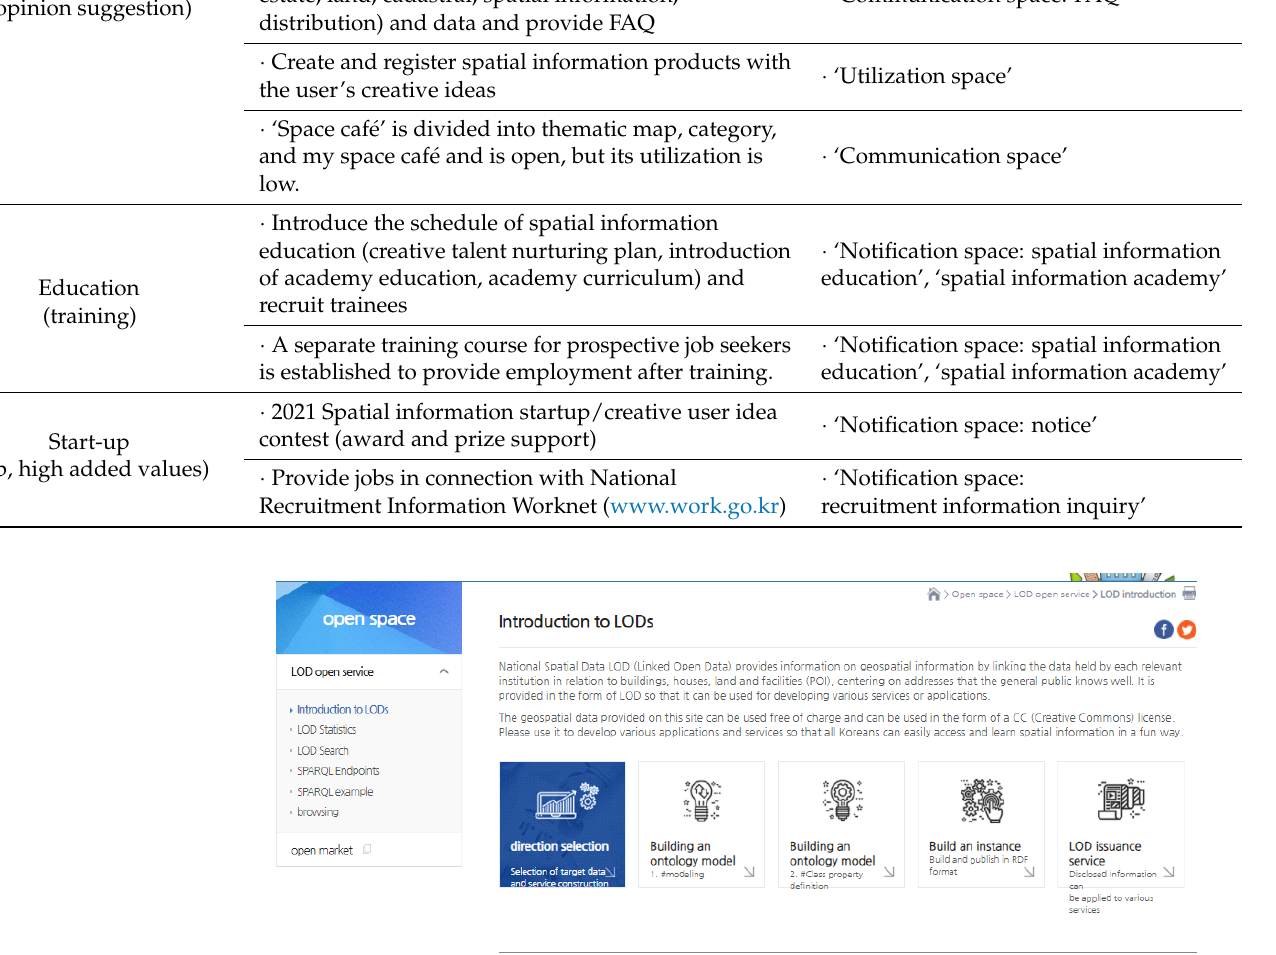
Figure 12. Providing spatial information by LOD in 'open space'. National spatial information LOD (linked open data) is provided in the form of LOD so that it can be used for application development by linking data related to buildings, houses, land, and facilities to addresses (Figure 12). The ontology model is a structure for expressing national spatial information data in RDF/XML format and consists of classes for buildings, houses, land, and facilities. The relationship of each class is connected with the address as the center. ‘What is spatial information?’ provides basic knowledge of spa- tial information by introducing the basic concept, necessity, and history of spatial infor- mation. Then, ‘spatial information utilization field’ mainly introduces the use of public institutions and industries. In the ‘use cases of government departments’, the user can review cases by linking public institutions through hyperlinks (Figure 13). In ‘notification space’, ‘notice’ provides a total of 502 notices divided into policy, real estate, land, cadas- tral, spatial information, and distribution.